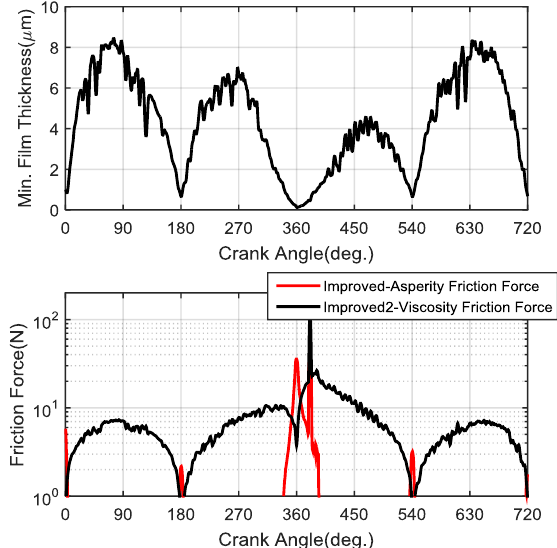
Figure 11. Minimum oil film thickness and friction force predicted based on improved model 2.